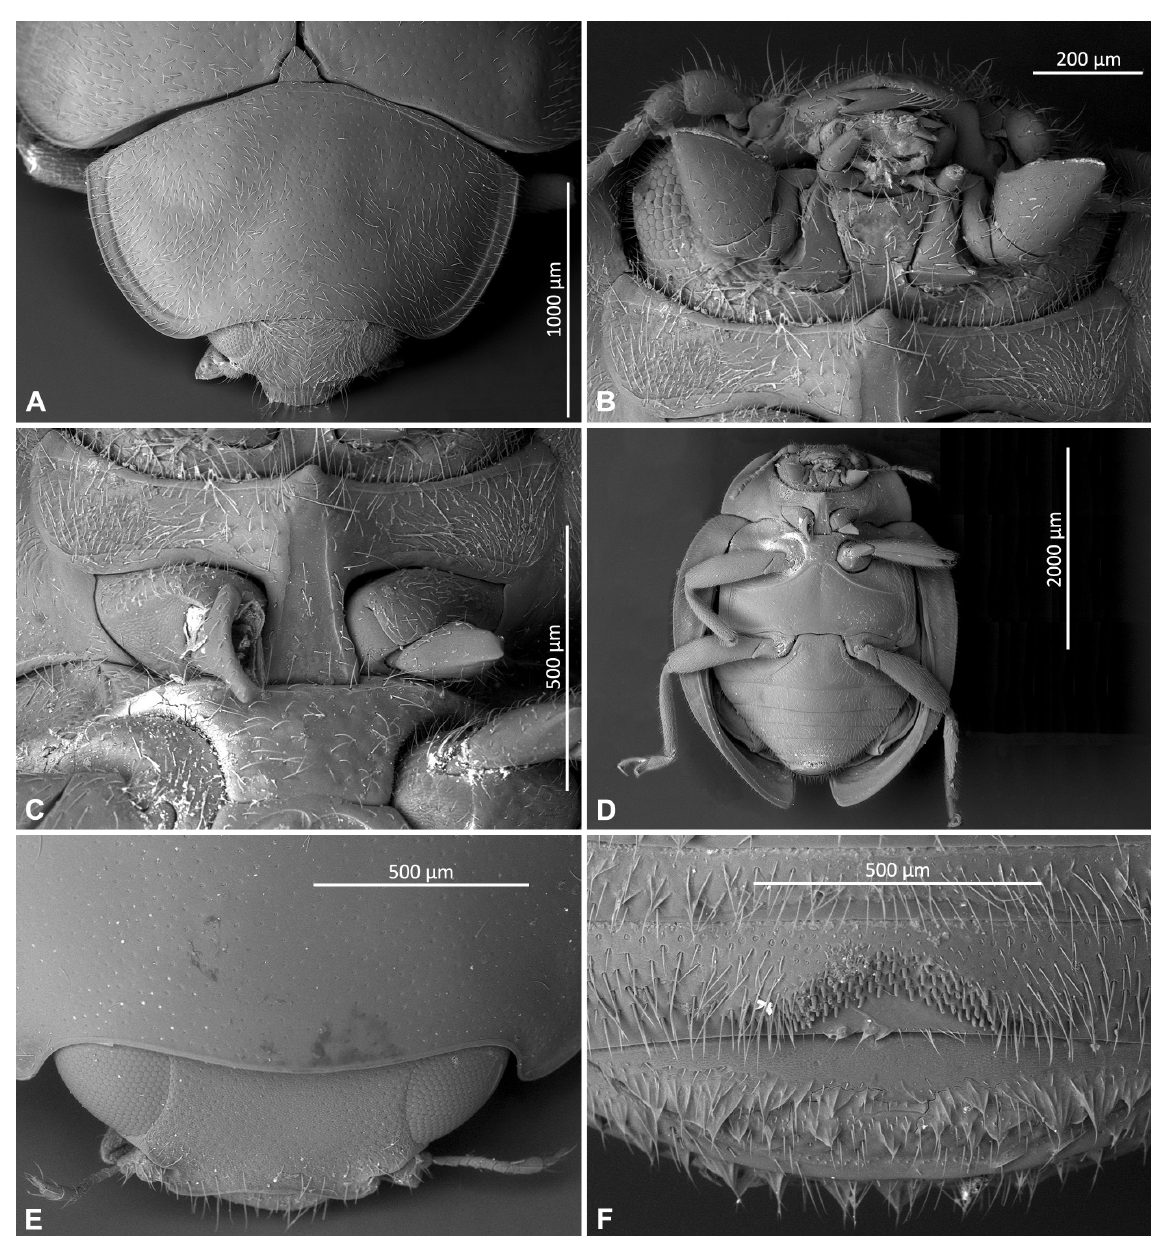
Fig. 3. SEM images. A–D . Eupalea borowieci sp. nov., paratype (MIZ). E . Hyperaspis rutai sp. nov., paratype (MIZ). F . Hinda ecuadorica Gordon & Canepari, 2013, ♂, (MIZ). A . Head and pronotum. B . Head, ventral. C . Prosternum and mesoventrite. D . Habitus, ventral view. E . Head, dorsal view. F . Distal part of abdomen, ventral